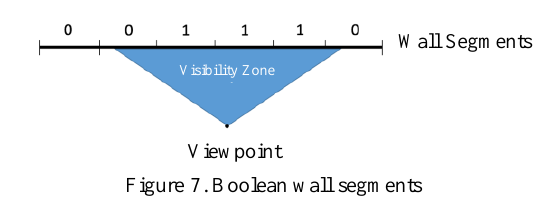
Figure 7. Boolean wall segments